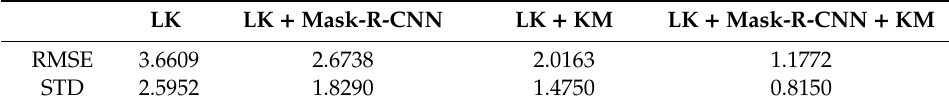
Table 5. Velocity errors of four algorithms in the X